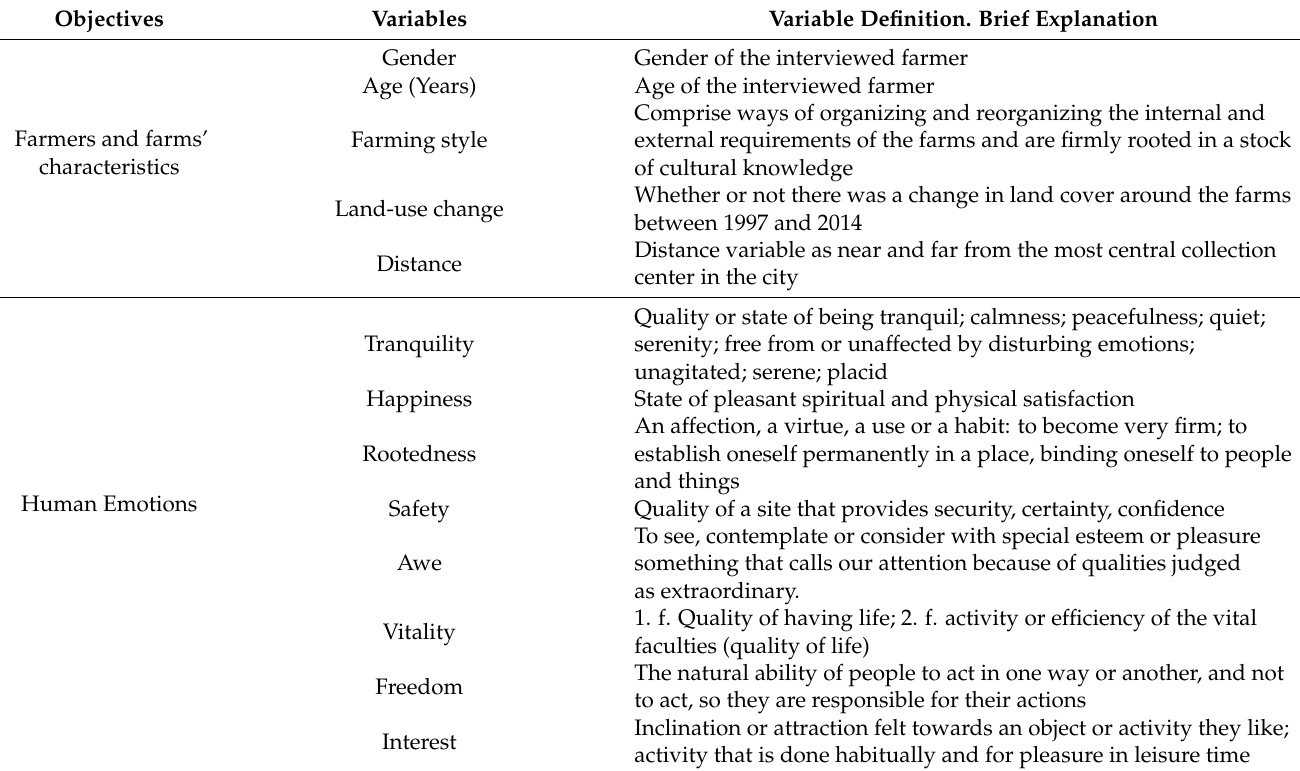
Table A1. Definition and summary of